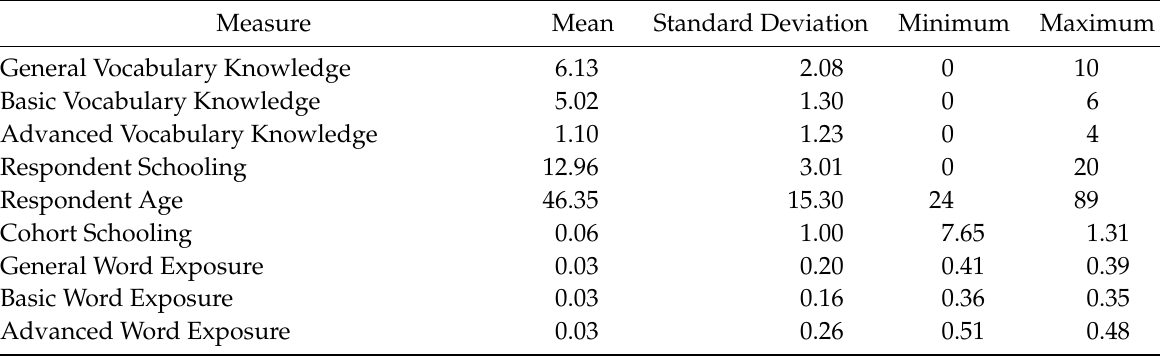
Table 1: Descriptive Statistics (N =